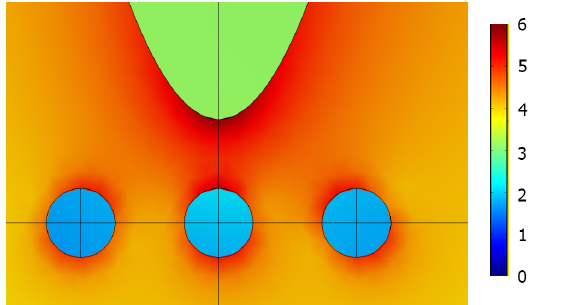
Figure 34. Tip heats magnetic nanoparticles (2nm) made of FePt alloy [232]. For the magnetic particle placed perfectly under the tip, the heat production is 1.4 times greater than the other neighboring particles, reprinted figure with permission from [189]. Copyright (2017) by the American Physical